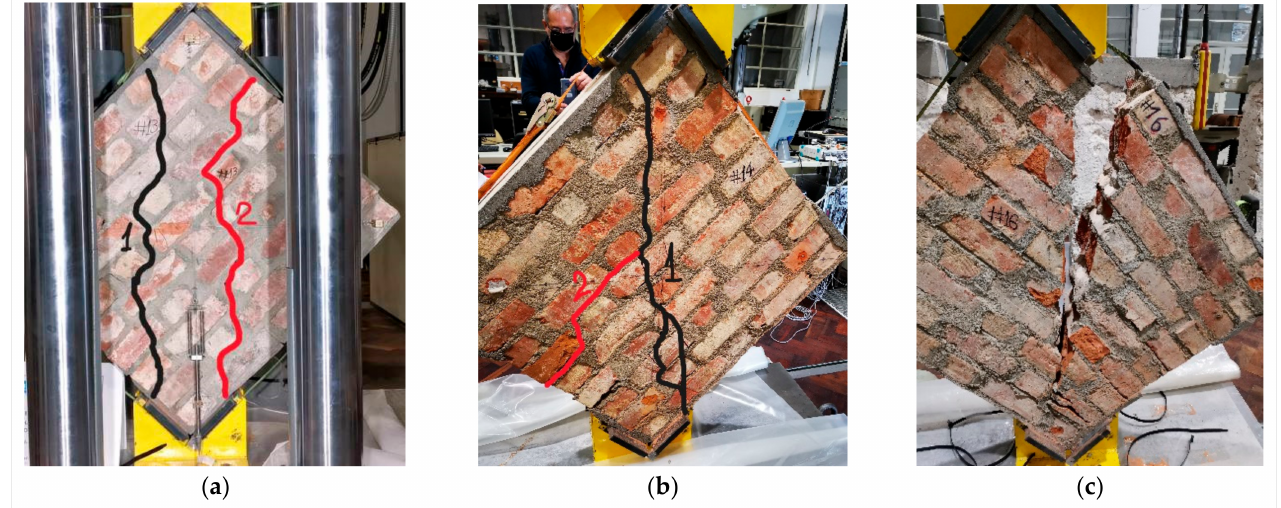
Figure 10. Crack patterns of the tested unreinforced wallettes. ( a ) UR-01; ( b ) UR-02; ( c )